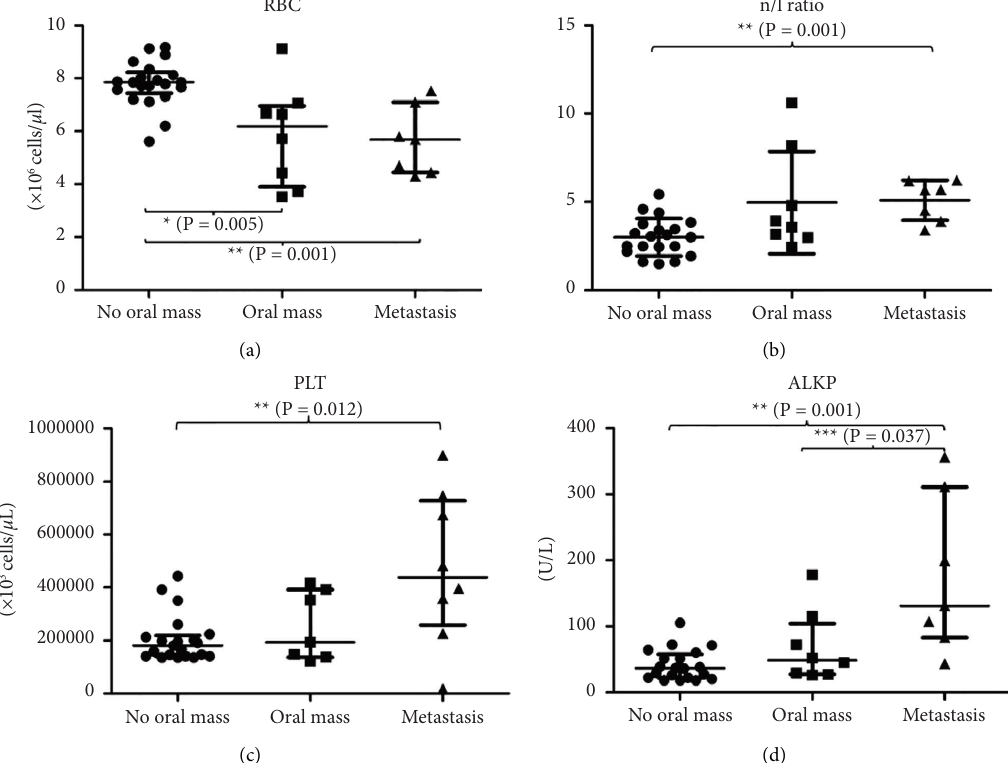
Figure 4: Comparison of red blood cell (RBC, median (IQR))(a), the neutrophil/lymphocyte ratio (n/l ratio or NLR, median (IQR))(b), platelet counts (PLT, median (IQR))(c), and alkaline phosphatase (ALKP, median (IQR))(d) of dogs among the no oral mass group, the oral mass group, and the metastasis